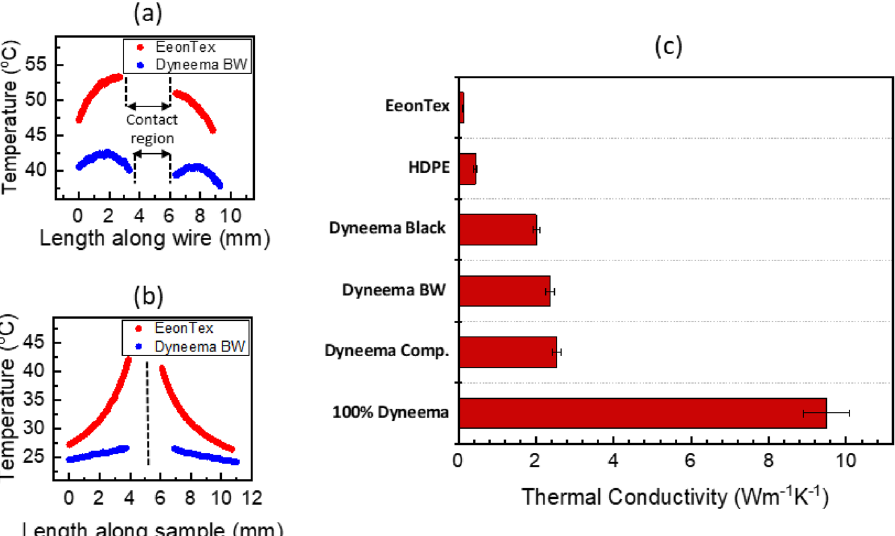
Figure 4. Representative temperature profiles of ( a ) the heating wire and ( b ) fabric sample obtained from IR thermal measurements of the Dyneema BW and EeonTex samples at the same electrical power input. The Dyneema BW sample exhibits significantly lower wire and sample temperatures, a steeper temperature gradient in the wire approaching the central region, and a relatively more linear sample temperature profile, which all are indicative of a higher in-plane thermal conductivity. ( c ) Measured effective in-plane thermal conductivity for the different